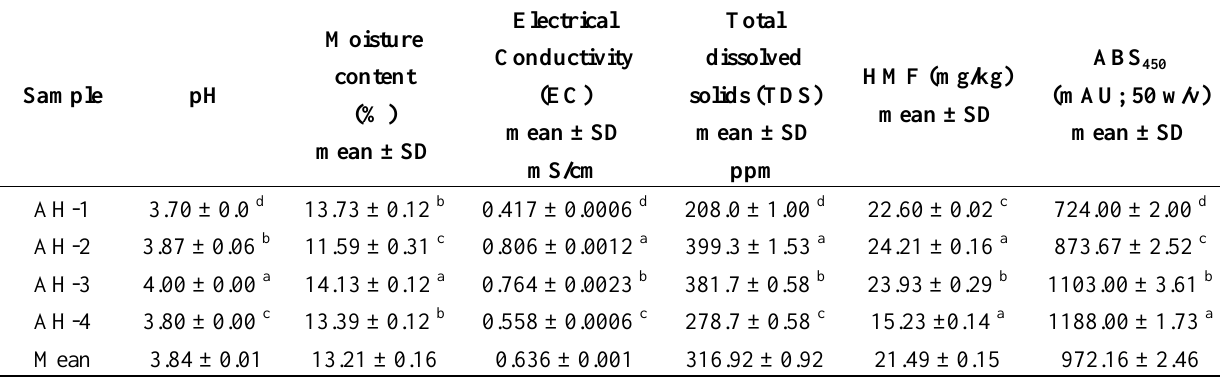
Table 1. Physical parameters (pH, moisture content, EC, TDS, color characteristics and HMF concentrations) of Algerian honey.